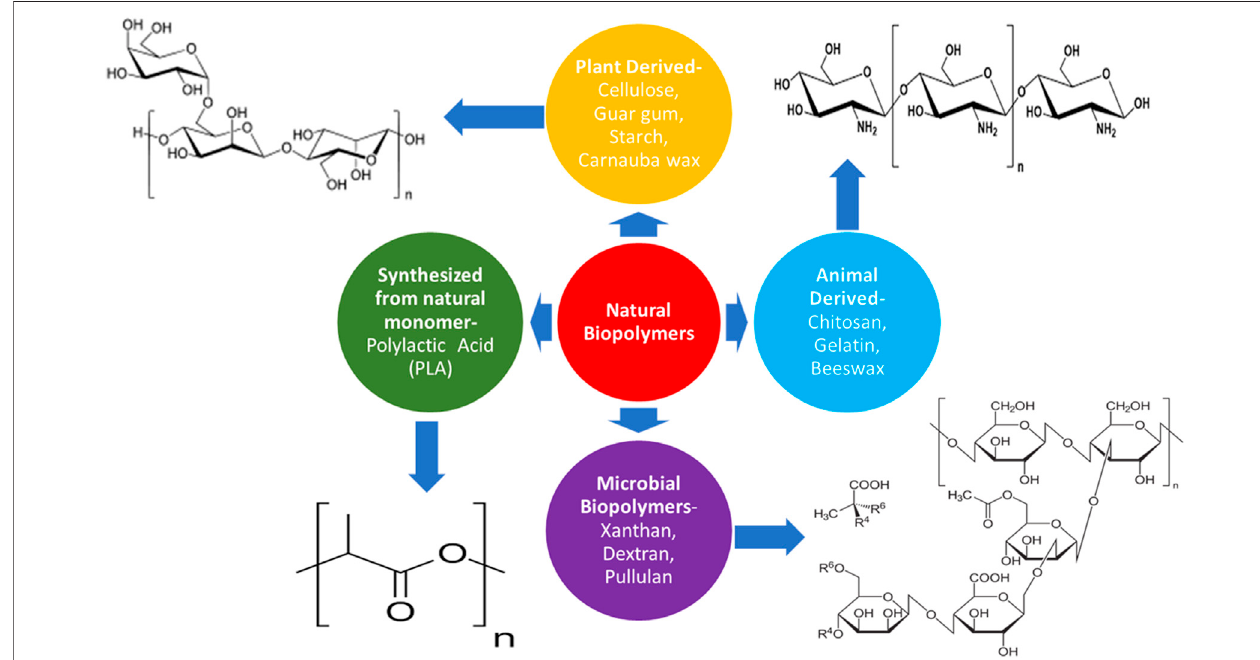
FIGURE 2 | Classi fi cation of natural biopolymers based on their sources.